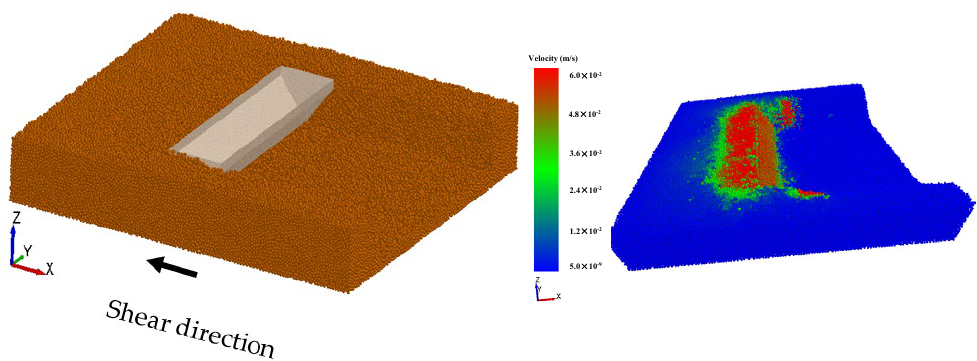
Figure 9. DEM simulation of soil shear test.